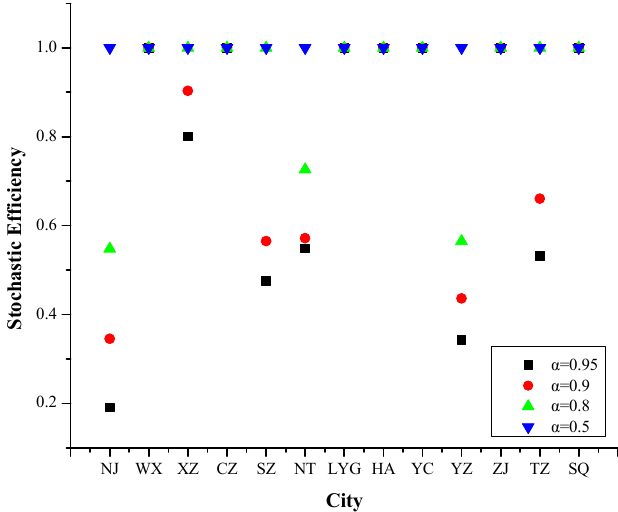
Figure 4. Stochastic efficiency values of 13 cities in Jiangsu Province at different risk levels in 2015.